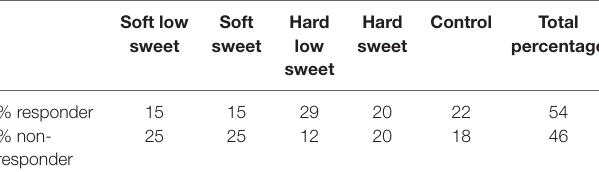
Table 2 | Percentage of responsive and non-responsive curves per treatment and control